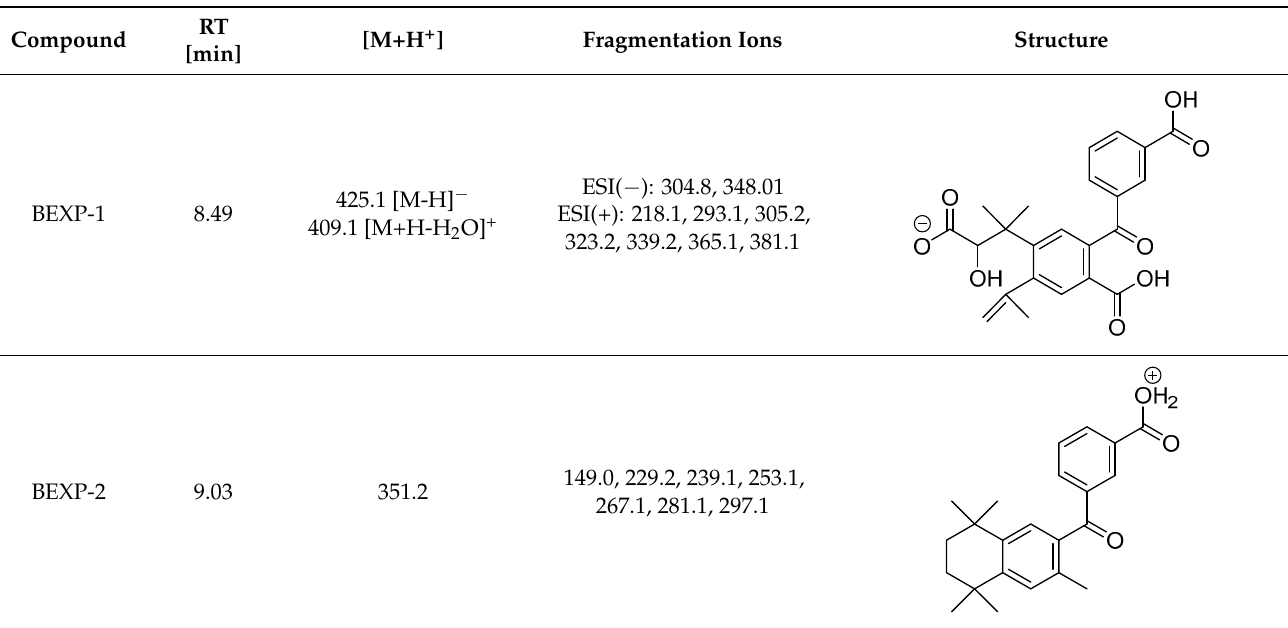
Table 1. Proposed structures of degradation products of bexarotene.